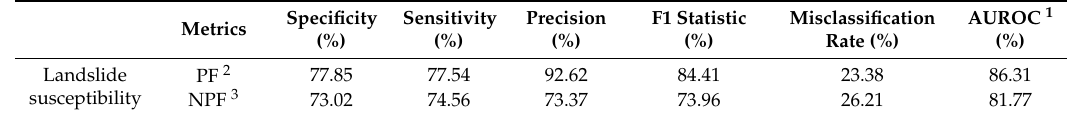
The results of the accuracy assessment of landslide susceptibility mapping based on the influential variables that control the occurrence of the landslide in the protected and non-protected forests.